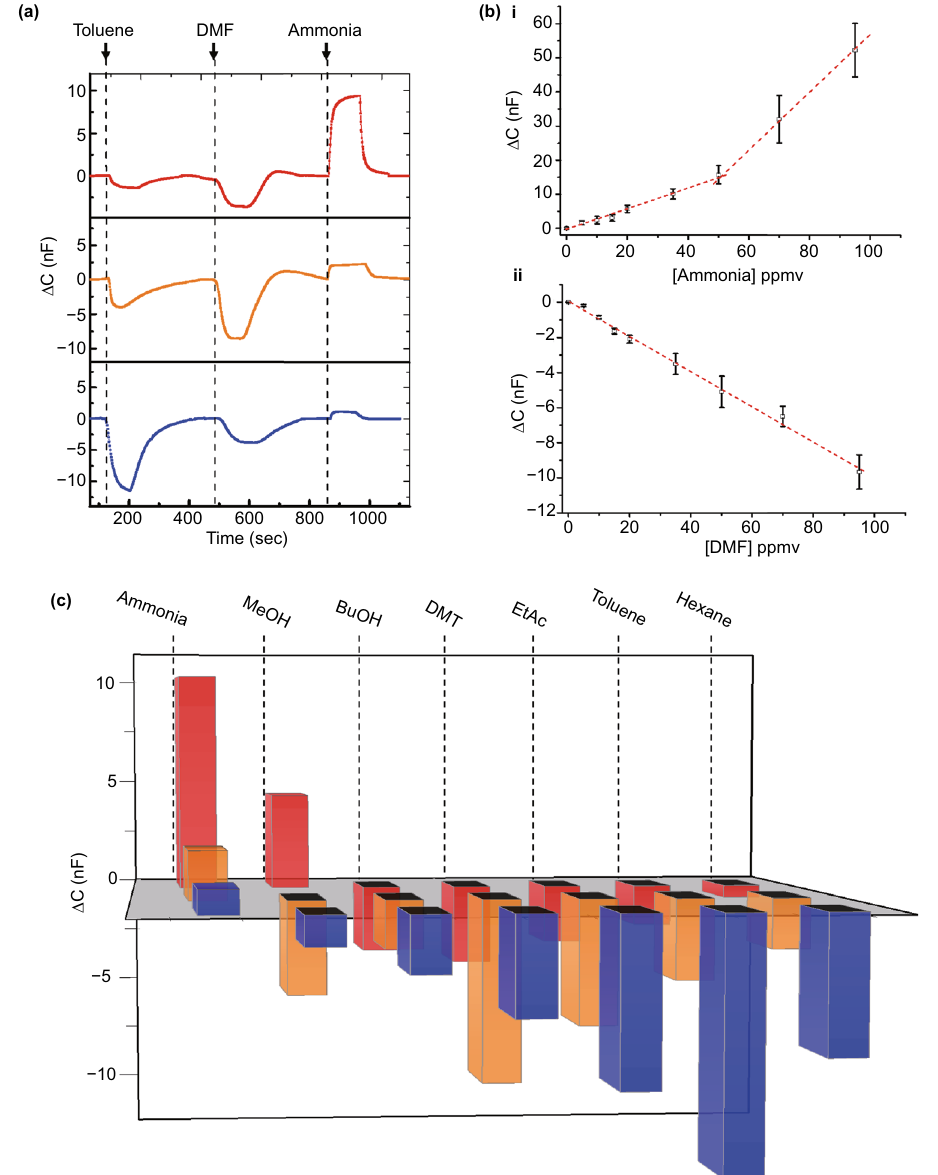
Fig. 2 Capacitive response of the carbon‑dot‑IDE sensors to gas vapors. a Capacitive transformation recorded for the red C‑dot‑IDE, orange C‑dot‑IDE and blue C‑dot‑IDE, respectively, upon exposure and subsequent purging of gas molecules. (Concentrations of all vapor molecules were 35 ppmv, determined by GC–MS.) The arrows indicate times of gas injection. Purging of the gases was carried out after the capacitance reached plateaus. The capacitance of a control IDE electrode without C‑dot deposited was not affected by humidity nor VOC. b Capacitive dose–response curves for ( i ) NH 3 , and ( ii ) DMF recorded for the red C‑dot‑IDE sensor. Linear fittings of the datapoints are presented; R 2 above 0.98 was obtained in all linear fits. c Bar diagram depicting the capacitance changes at saturation following exposure of the C‑dot‑IDEs to gas molecules at a concentration of 35 ppmv. The bars represent an average value of five replicates per each electrode. (Color figure